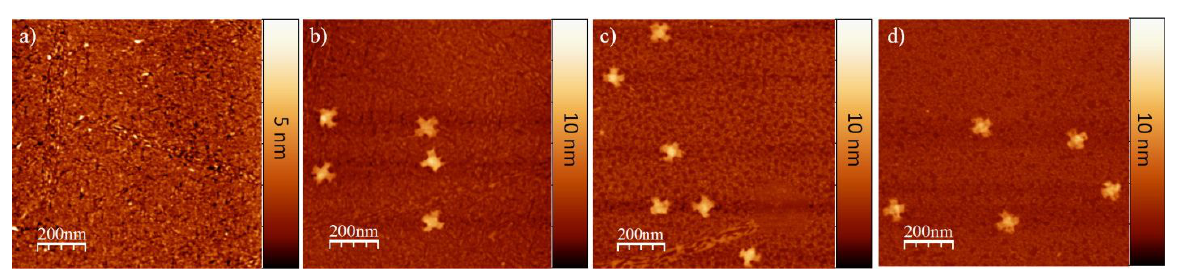
Figure 3: (a) AFM image of the MoS 2 basal plane after exposure to 0.5 mM 1-pyrenemethylamine methanol solution for 5 min. (b) DNA origami with a cross shape imaged immediately after deposition onto pre-modified MoS 2 substrates. (c) AFM images of DNA origami adsorbed on the MoS 2 after 24 h and (d) 48 h.